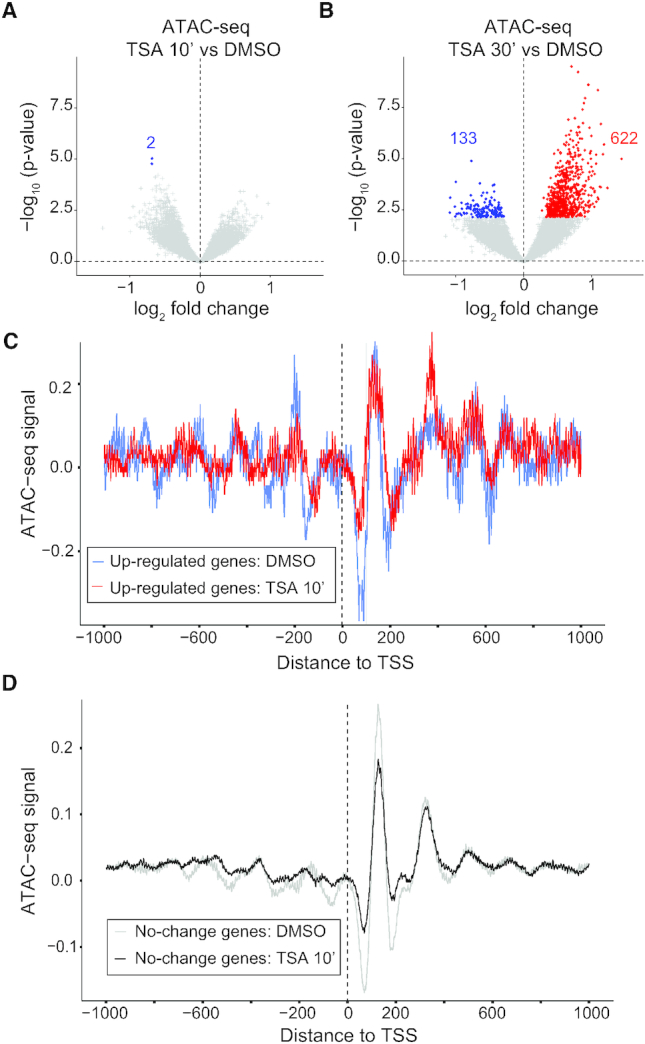
Chromatin accessibility and nucleosome positioning is similar in control and HDAC inhibitor-treated cells. (A and B) Volcano plots of ATAC-seq log2 fold change versus –log10P-values on the ATAC-seq peak regions in S2 cells treated with TSA versus DMSO control for 10 min (A) or 30 min (B). (C and D) Nucleosome position ±1 kb around the TSS from ATAC-seq data in DMSO or 10 min TSA-treated cells for 96 up-regulated genes (C) and non-affected genes (D) after 10 min of TSA.